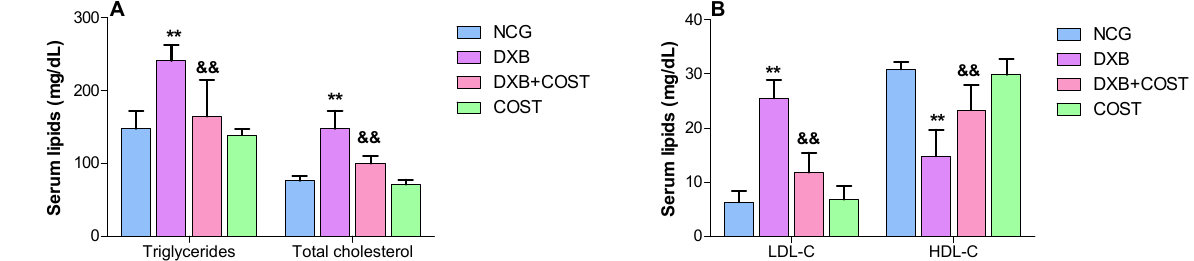
Figure 3. Effect of costunolide on: ( A ): serum triglycerides and total cholesterol, ( B ): serum LDL-C and HDL-C. ** Statistically significant ( p < 0.01) compared with NCG and COST groups. && Statistically significant ( p < 0.01) compared with DXB group.